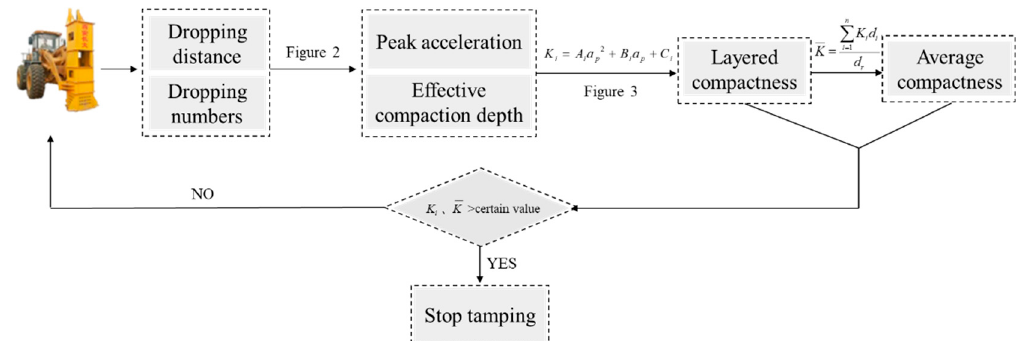
Figure 13. Flow chart of real-time monitoring for the compaction quality of loess subgrade.